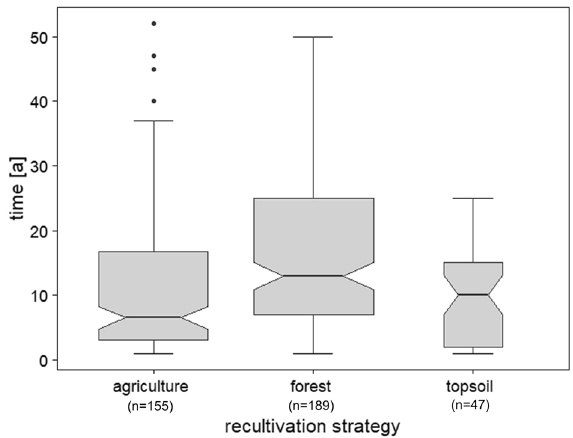
Figure 3. Time period covered by the entirety of individual observations that make up each of the three main strategies, respectively. Each box contains the middle 50% of the data of a category. The mean of the data is shown as a horizontal solid line within the box. The whiskers indicate the lower and upper quartile of the data, respectively, and are limited to 1.5 times the interquartile range. Notches represent the 95% confidence interval of the mean. Agroforestry was omitted from this figure, as all values within this category stem from one study and represent a single point in